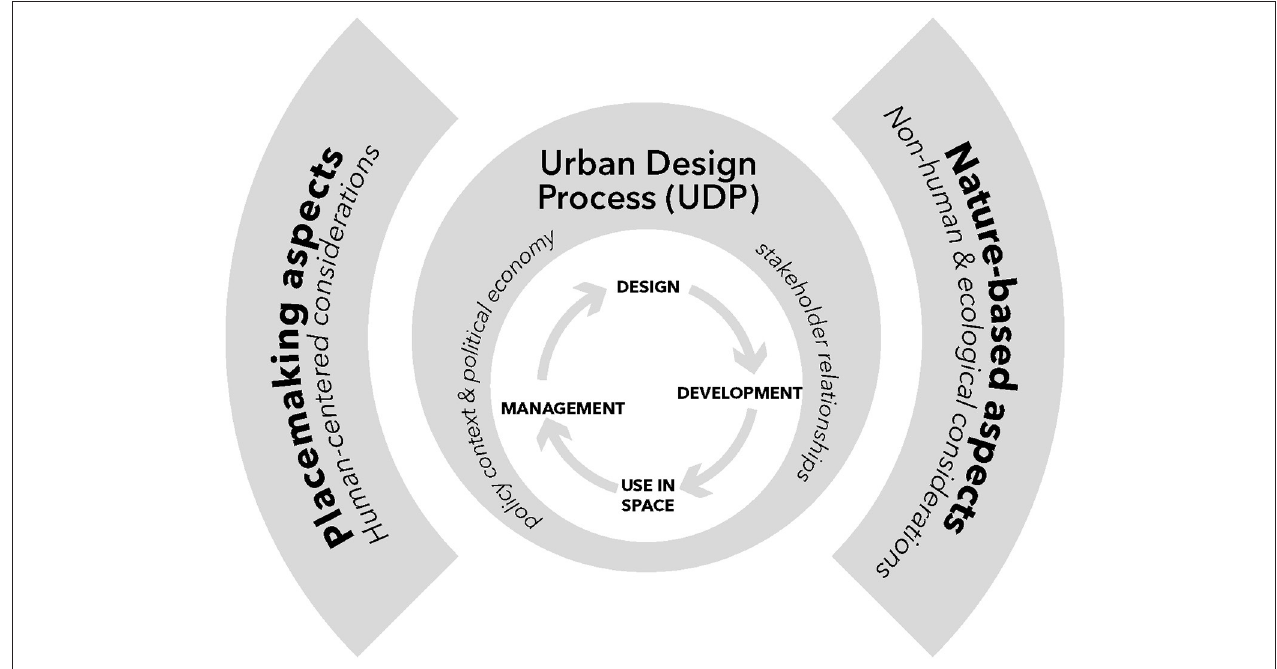
FIGURE 1 | Urban design process dimensions viewed from the lens of placemaking and nature-based solutions. Adapted from Carmona